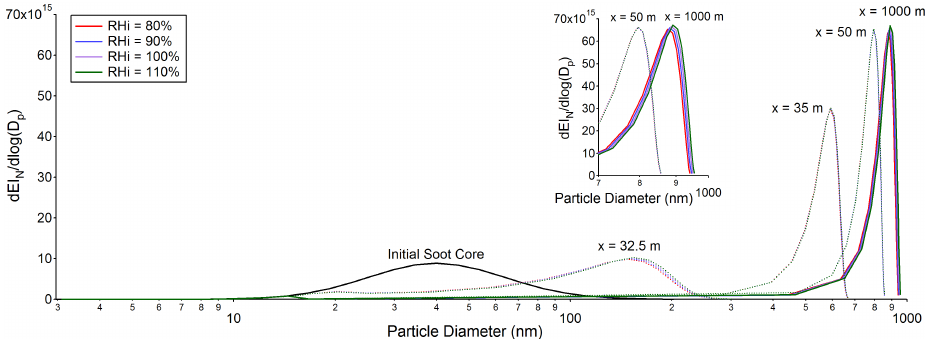
Fig. 5. Effects of ambient relative humidity with respect to ice (RHI) on ice particle size distributions at downstream distances of 32.5m, 35m, 50m, and 1000m.